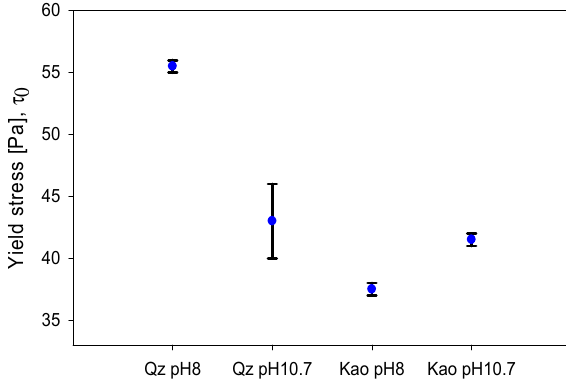
Figure 7. Yield stress for quartz and kaolin slurries at different pH levels.